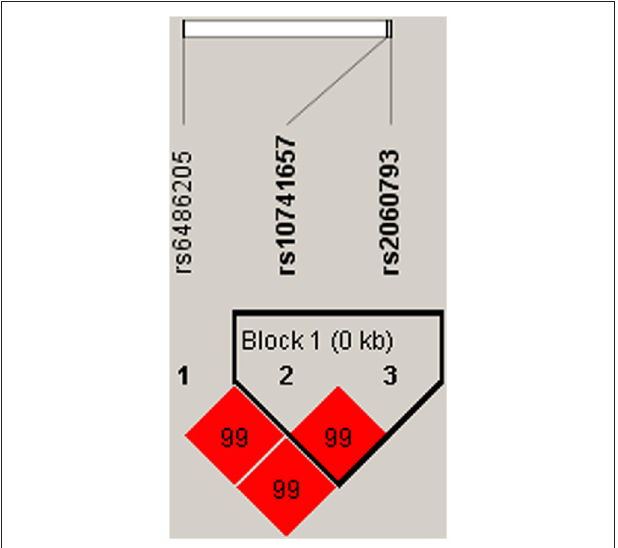
TABLE 7 | MDR analysis for CYP2R1 SNP–SNP interaction and CYP2R1 gene–environment interaction with CHD risk.